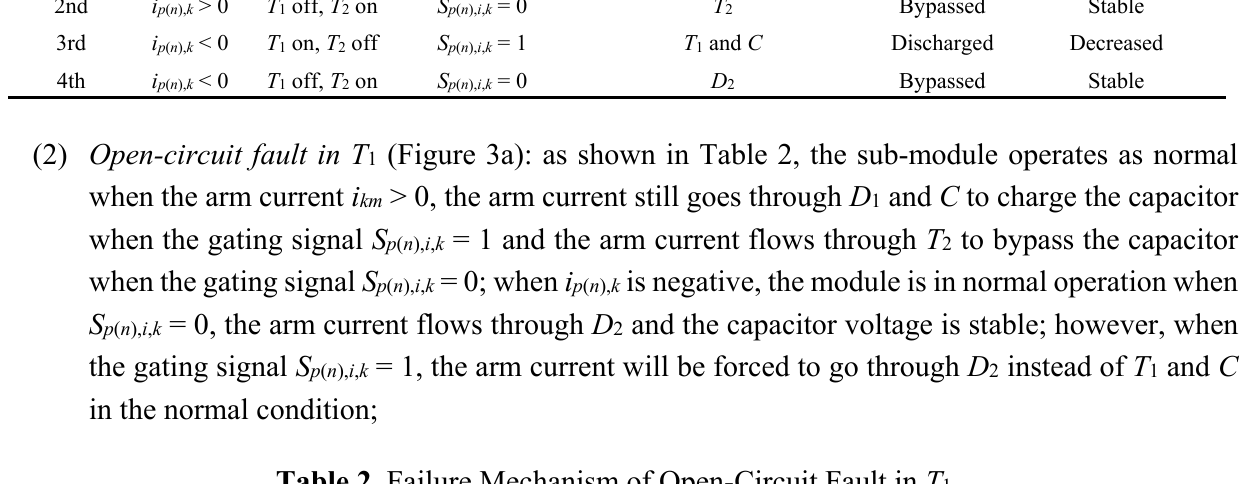
Table 2. Failure Mechanism of Open-Circuit Fault in T 1 .